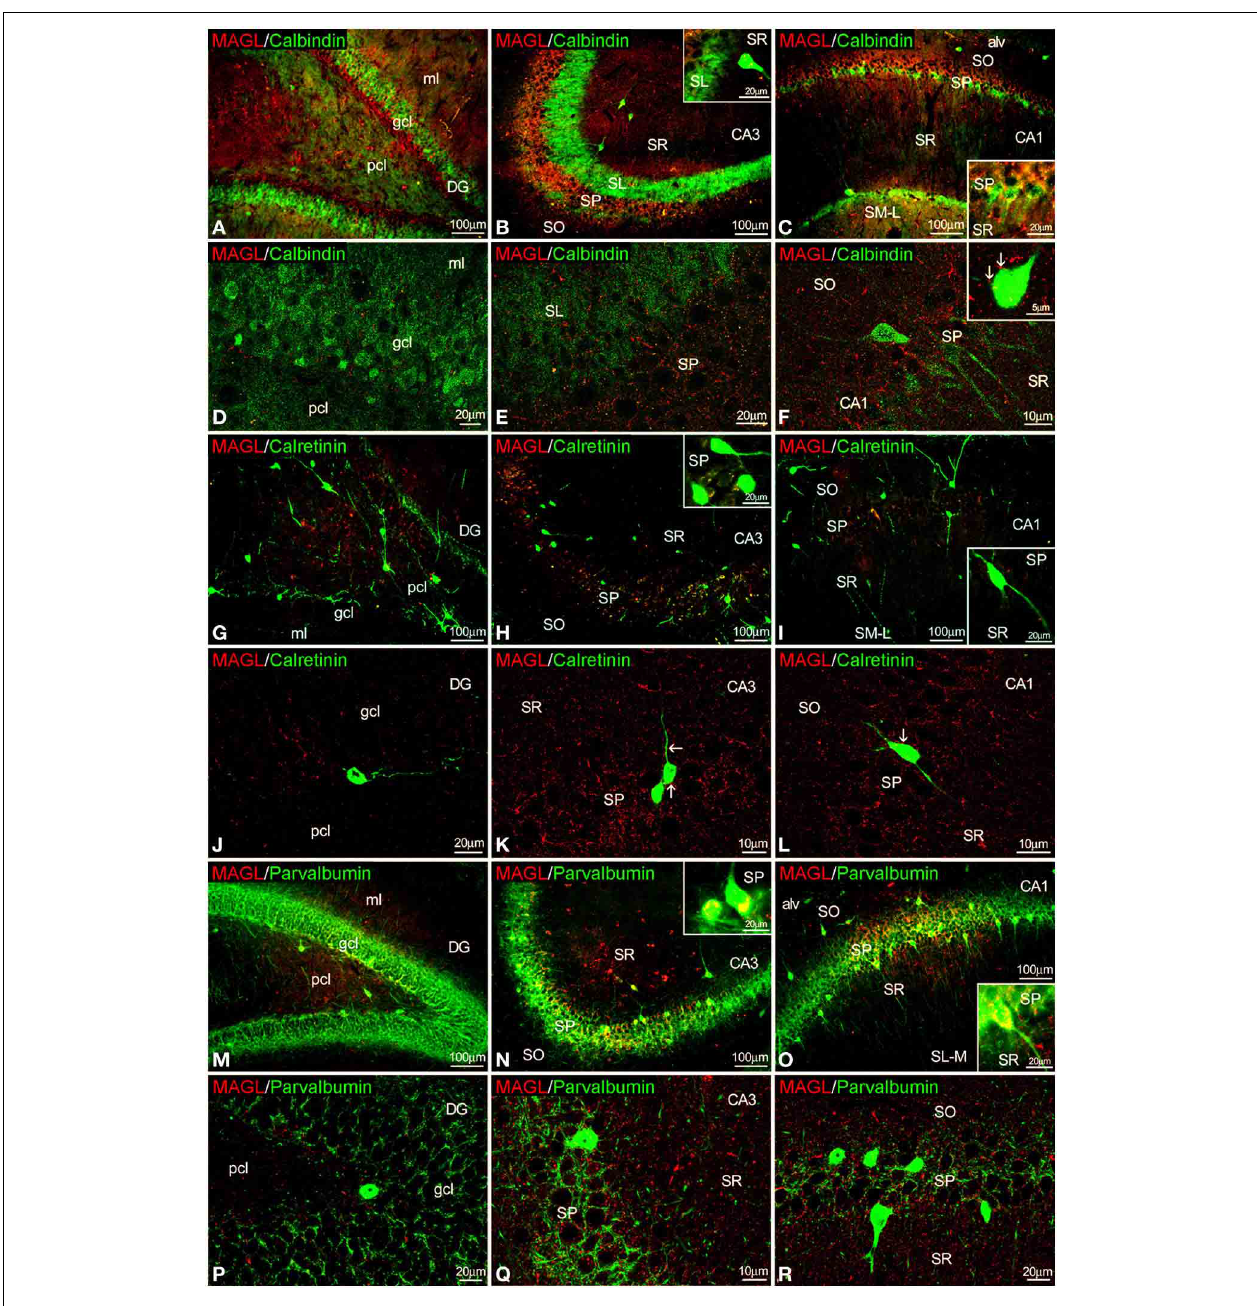
FIGURE 5 | Co-localization of MAGL and calbindin, calretinin, or parvalbumin in the rat hippocampus. Low resolution epifluorescence photomicrographs (A–C,G–I,M–O) and high resolution confocal laser scanning photomicrographs (D–F,J–L,P–R) showing labeling for calbindin,